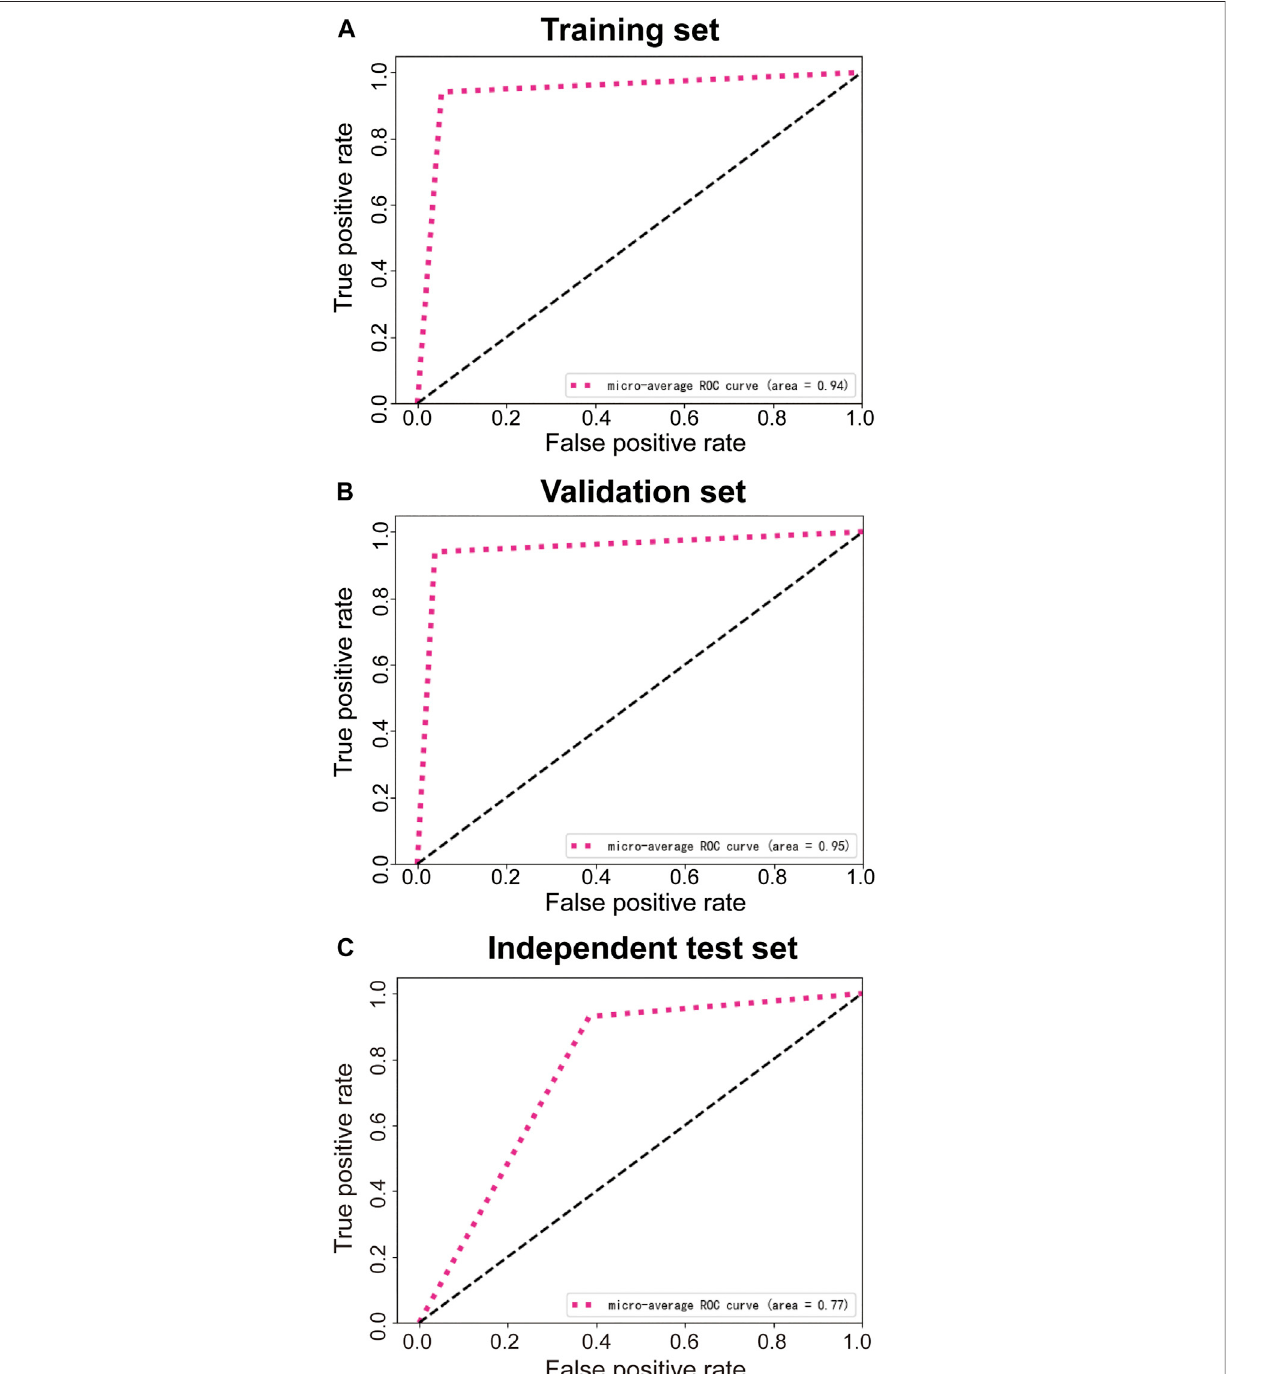
FIGURE 4 | ROC curves of the training set (A) , validation set (B) , and independent test set (C) . ROC, receiver operating characteristic.